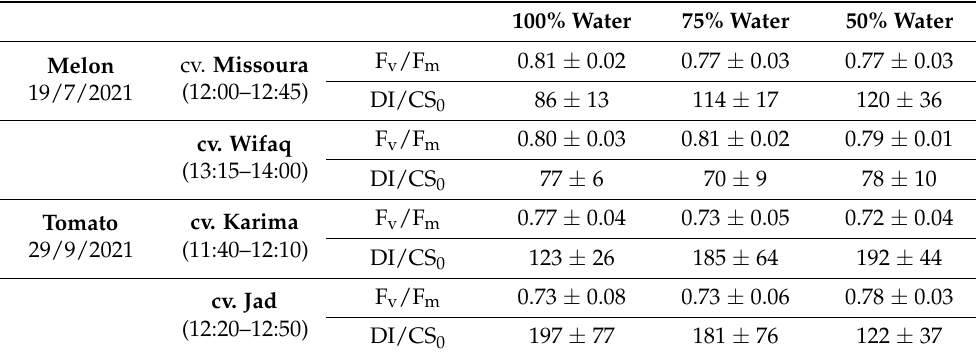
Table 1. Fluorescence parameters (F v /F m and DI/CS 0 ) of melon and tomato plants grown under three strategies of irrigation (100%, 75% and 50% water).